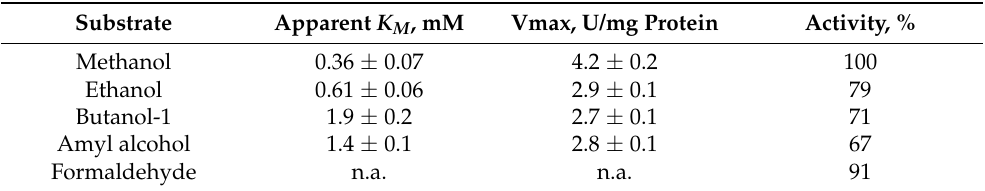
Table 3. The used buffer solutions and corresponding MDH-His 6 -tag activities. Buffer Solution, 0.1M pH Activity, % Acetate-NaOH 4 56.1 ± 0.6 Acetate-NaOH 5 77 ± 3 KH 2 PO 4 -NaOH 6 84 ± 2 KH 2 PO 4 -NaOH 7 92 ± 3 Tris-HCl 8 92 ± 2 Tris-HCl 9 100 Glycine-NaOH 10 93 ± 0.2 Na 2 HPO 4 -NaOH 11 91 ± 0.1